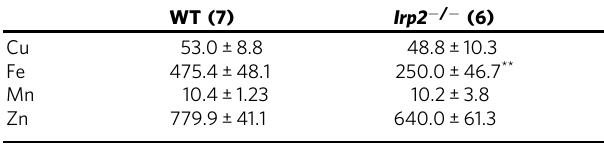
Table 1 Metal content in WT and Irp2 − / −